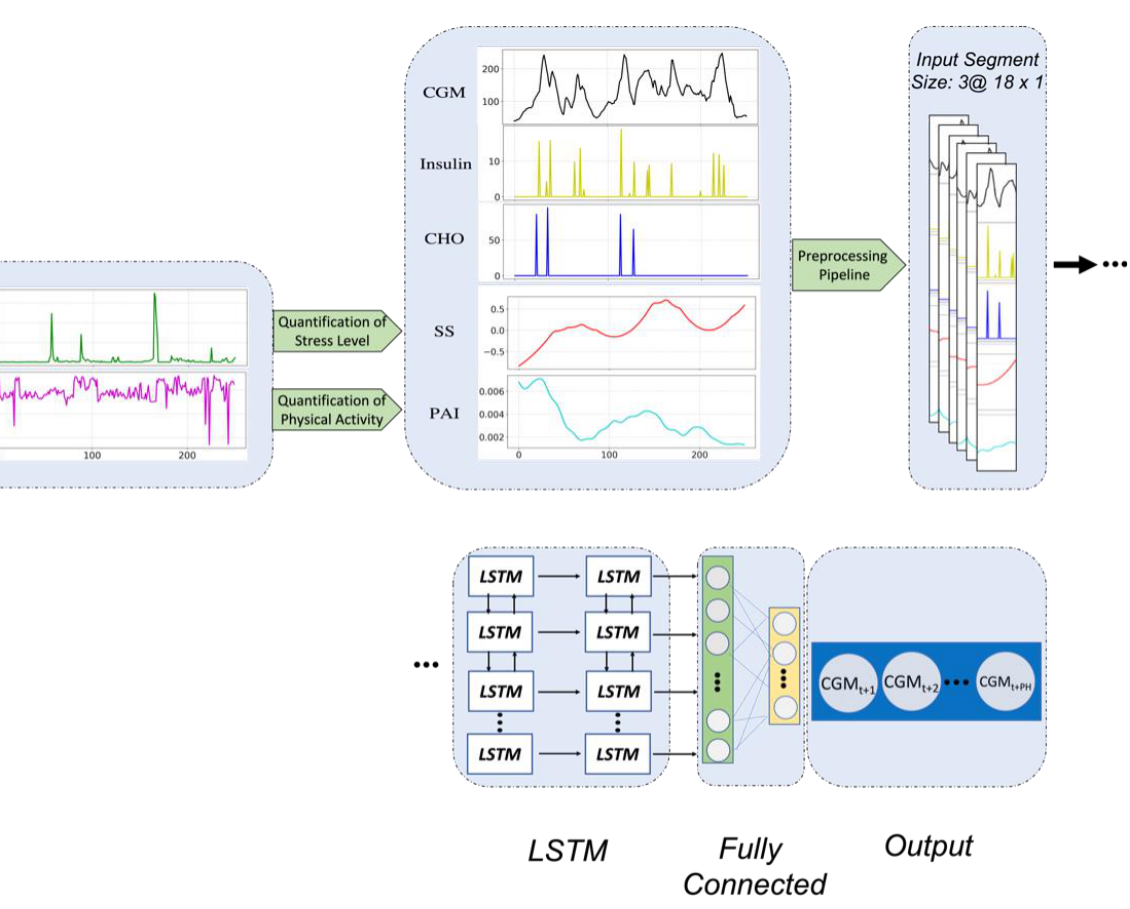
Figure 3. The architecture of the proposed LSTM model. Raw ACC and EDA signals are used to estimate PAI and SSI features, respectively. Then, these obtained features, are combined with the CGM, insulin, and CHO timeseries and are passed through the preprocessing.